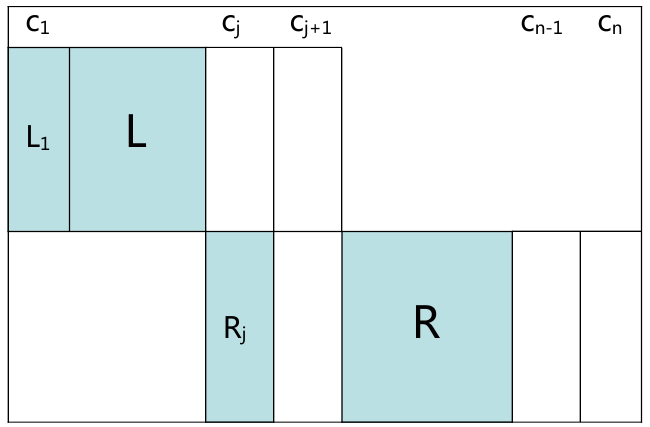
Figure 19 . Maximally constructing full cells from full cells through the re(cid:12)ned BCFW recursion